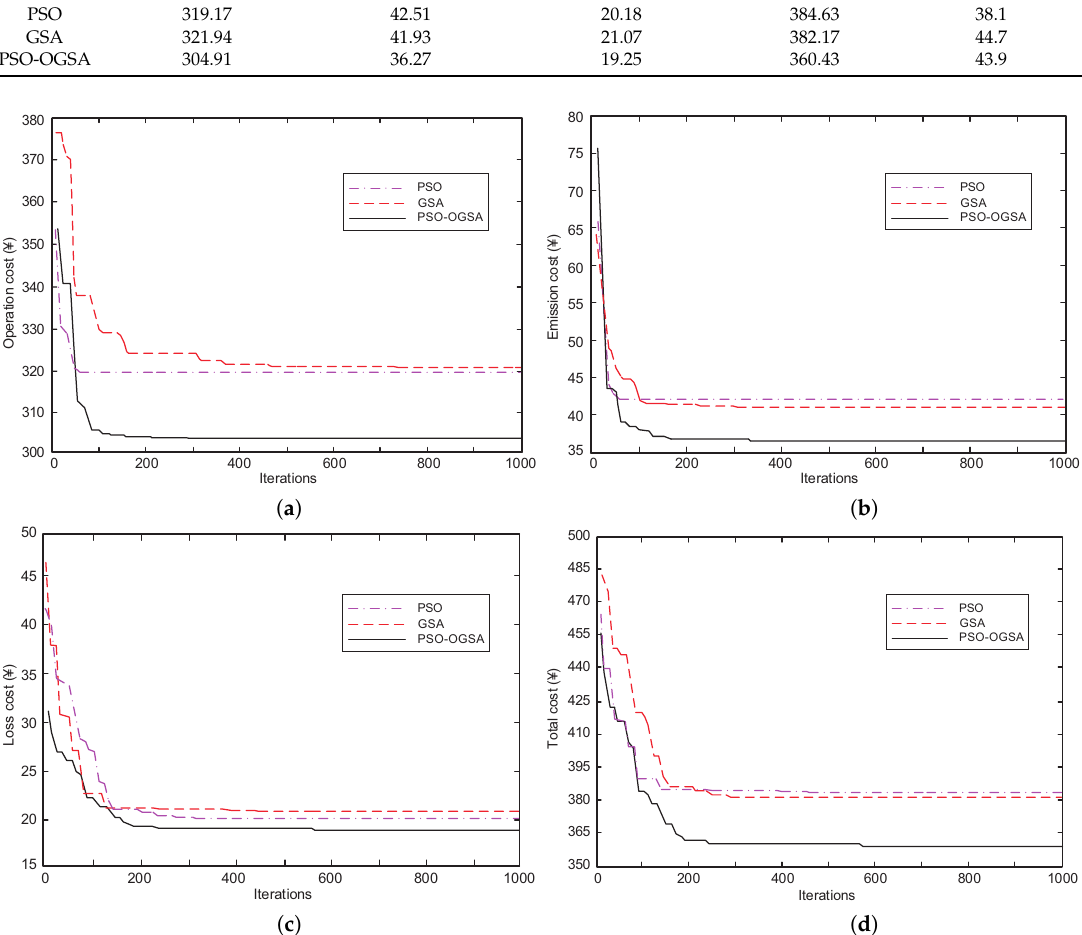
Figure 8. Comparative convergence for the GSA, PSO and PSO-OGSA for test microgrid. ( a ) Operation cost. ( b ) Emission cost. ( c ) Loss cost. ( d ) Total